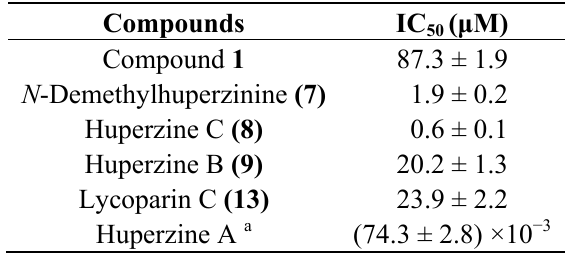
Table 3. AChE inhibiting activity of compounds 1 , 7 , 8 , 9 and 13